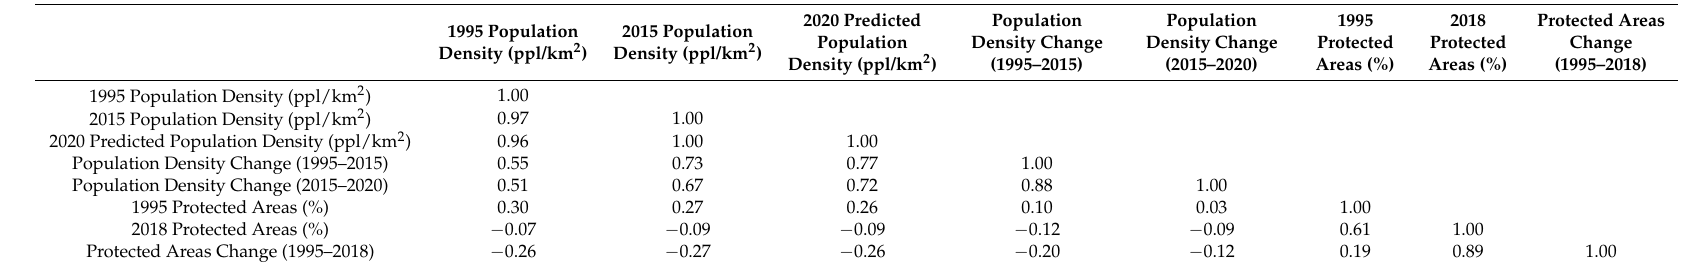
Table A3. Correlation Coefficients for Population Density and Protected Area in Biodiversity